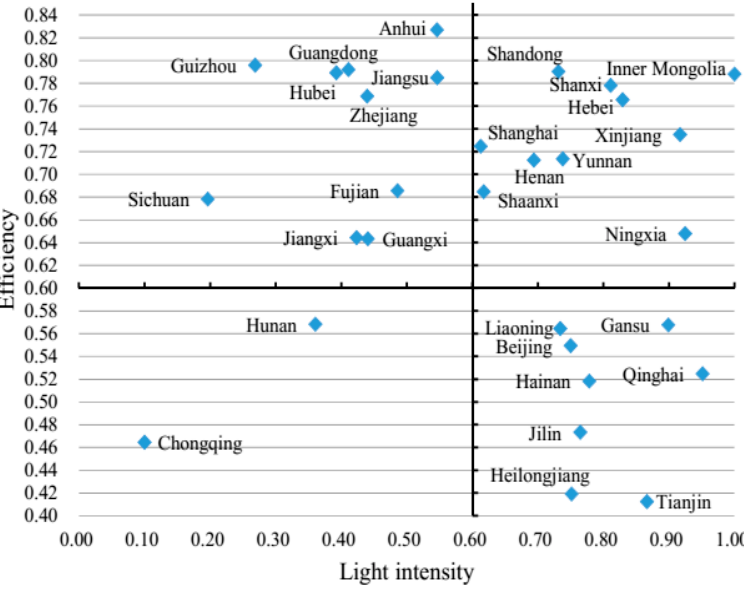
Figure 7. Categorizations of light intensity and efficiency of the 30 regions.